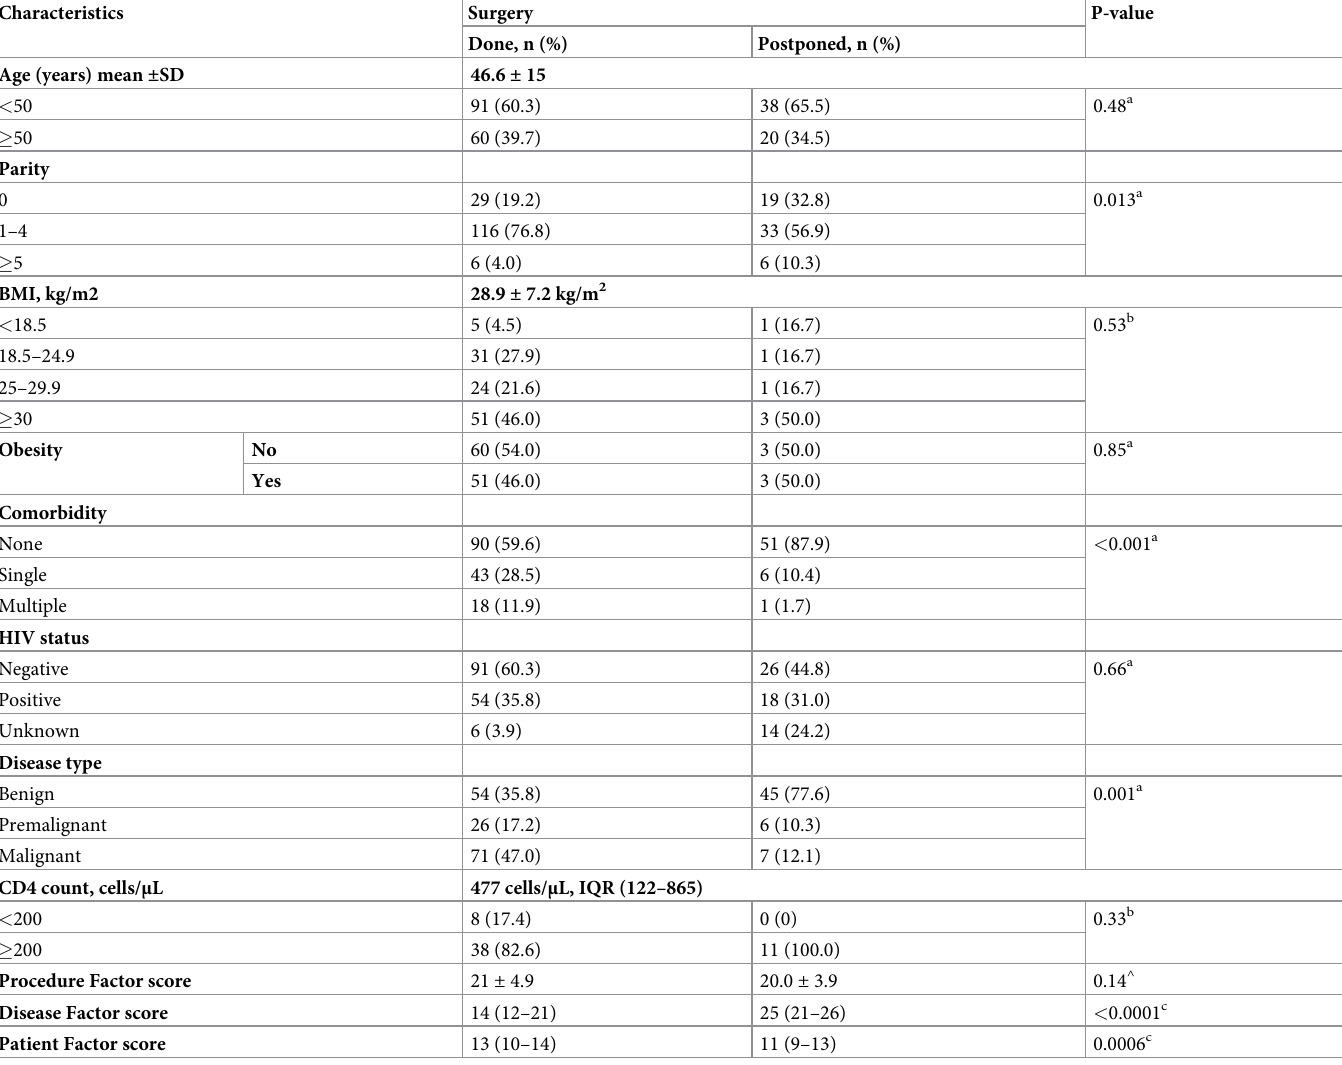
Table 1. Comparison of the baseline demographic characteristics between those operated and not